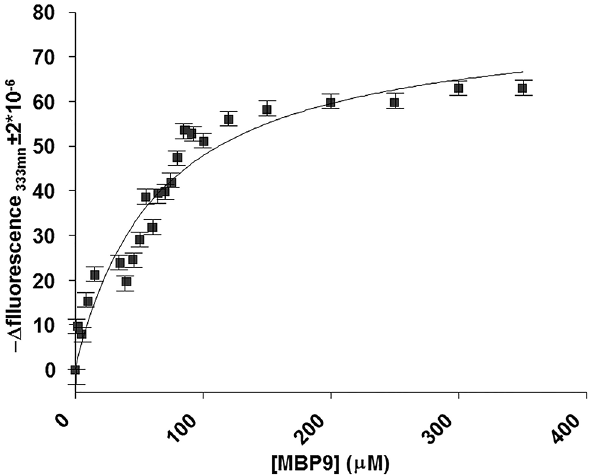
Fig 6. Tryptophan fluorescence quenching analysis showing the dose-response curve of the fluorescence values of MBP protein at 333nm plotted against the concentration values of MPB-9.